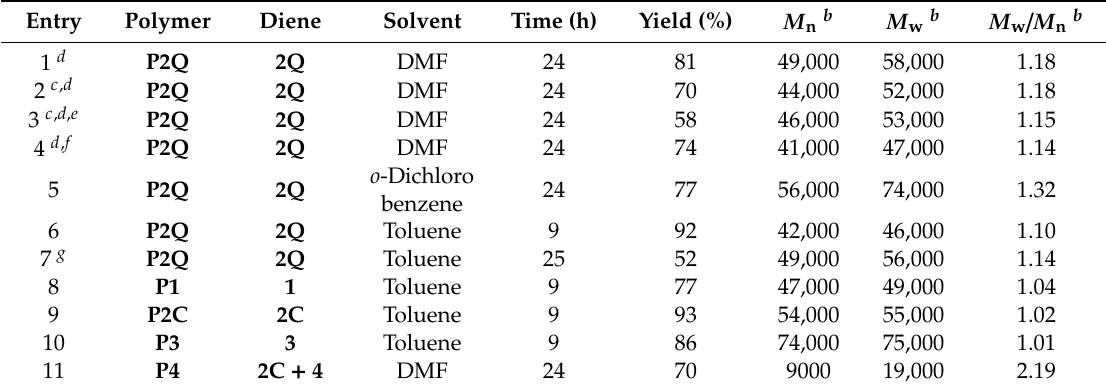
Table 1. Synthesis of P1–P4 by acyclic diene metathesis (ADMET) polymerization a .